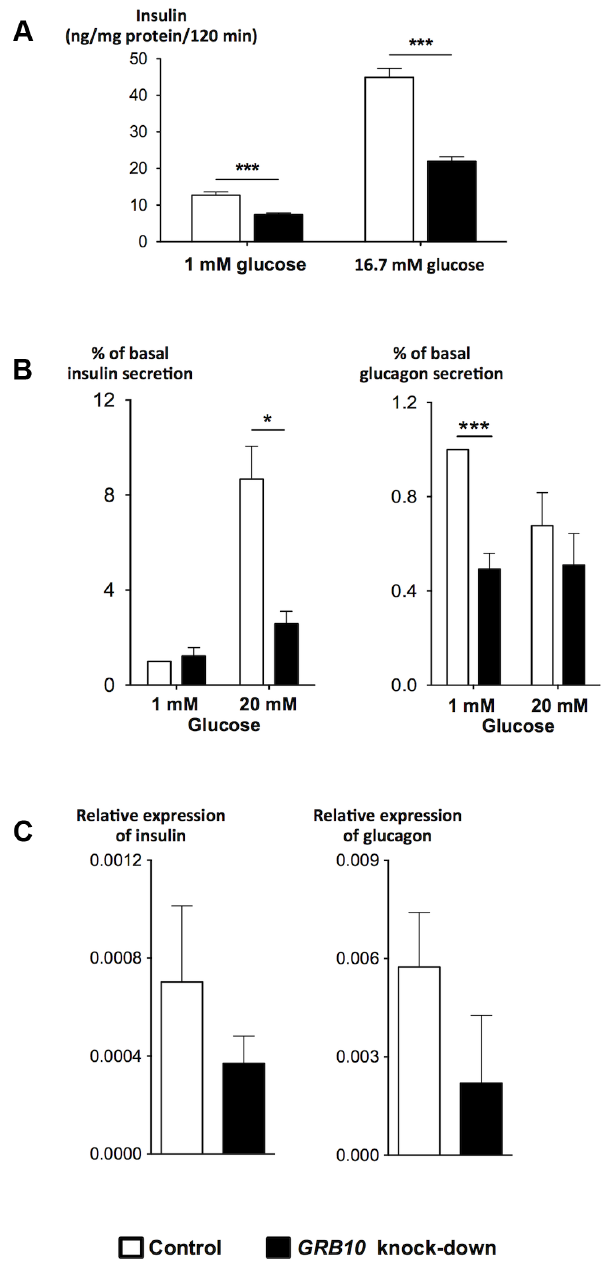
Figure 4. Effects of disrupted GRB10 through knock-down on islet function. (A) Disrupted GRB10 in INS-1 rat b -cells markedly reduced glucose-stimulated insulin secretion. (B) GRB10 knock-down showed reduced glucose-stimulated insulin secretion at 20 mM glucose and glucagon secretion at 1 mM glucose in human pancreatic islets (N insulin =7, N glucagon =6 donors of human pancreatic islets; 3–6 measurements in each experiment for each donor). (C) GRB10 knock- down resulted in a reduction of insulin and glucagon mRNA expression (N=3 donors of human pancreatic islets; 3 measurements in each experiment for each donor). * p , 0.05; ** p , 0.01, *** p , 0.001. Error bars denote